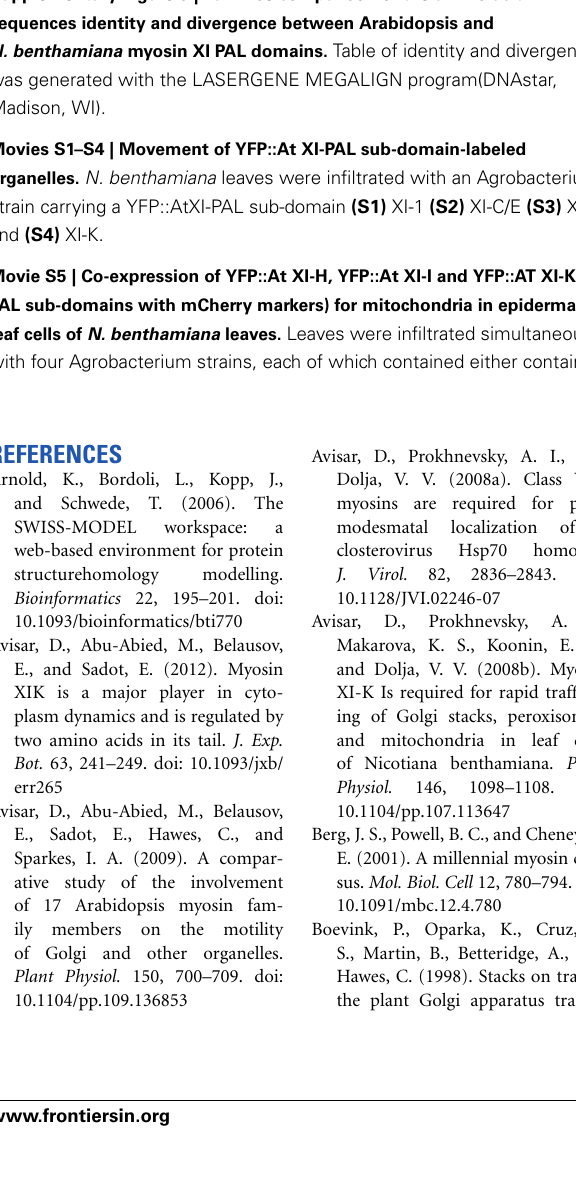
images of YFP (yellow) and mCherry (red). Scale bar = 10 μ m.